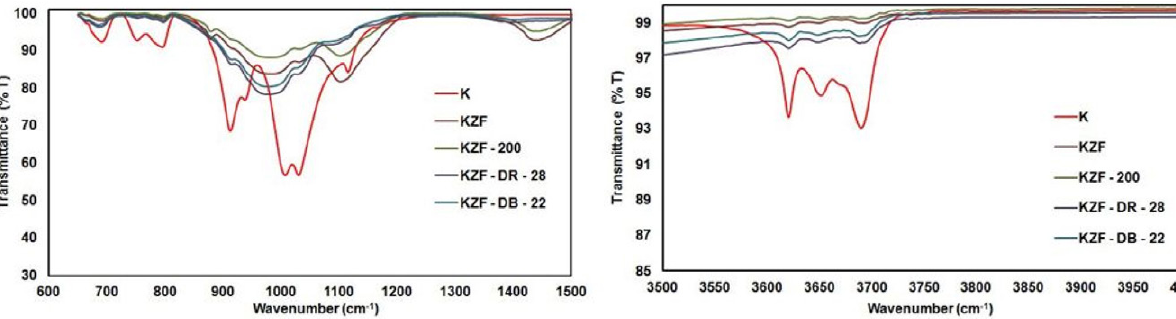
Fig. 2. FTIR spectra of K, KZF, KZF-200, and dye adsorbed KZF